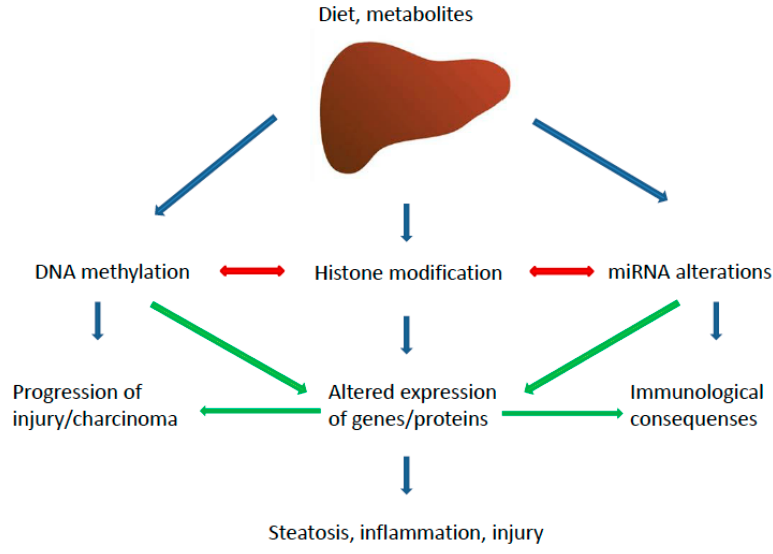
Figure 2. Epigenetic pathways implicated in the pathogenesis of NASH. The major pathways and their main effectors are depicted. main effectors are